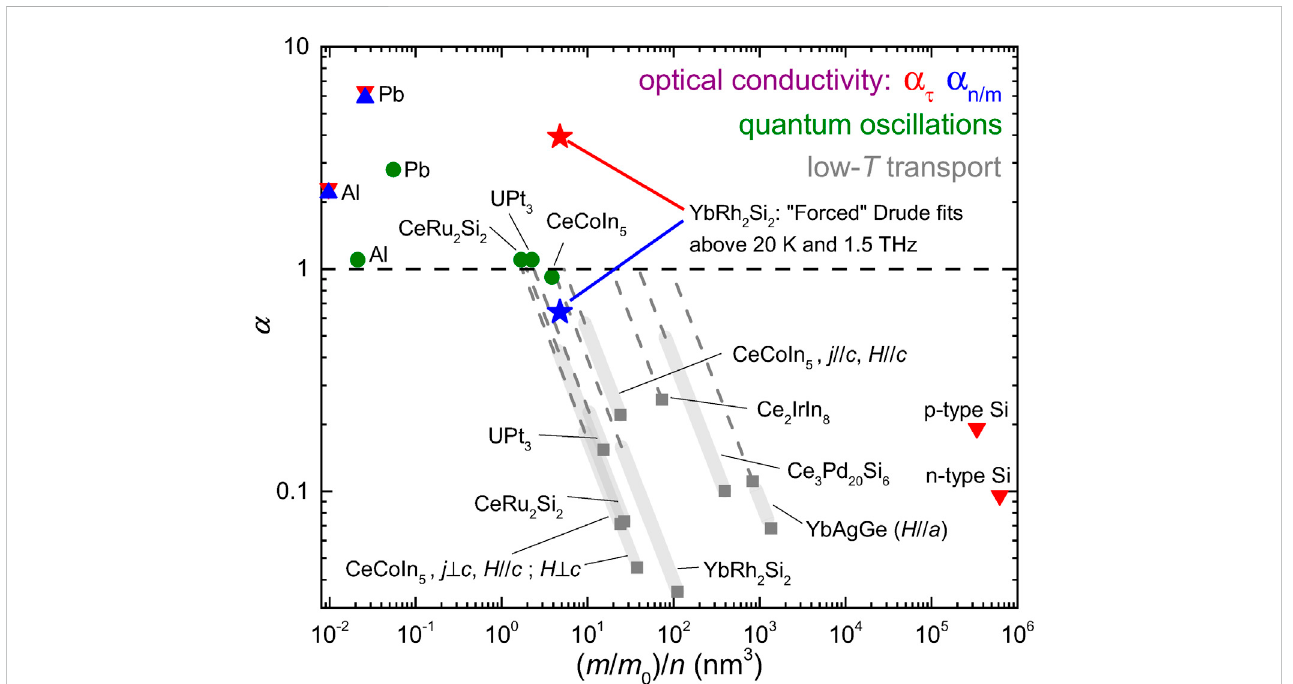
FIGURE 4 ResultsofvariousPlanckiananalyses,inadouble-logarithmicplotof α vs.( m / m 0 )/ n .Thedarkgreysquaresandthebroadlightgreylineswereobtainedin (Taupin and Paschen, 2022) from low-temperature transport measurements. The dashed grey lines are extrapolations to the dashed black α = 1 line of Planckian dissipation.Note that thegrey lines — α vs.( m / m 0 )/ n curves obtained fromEq.13 — are straightlinesof slope − 1 on thisdouble-logarithmic plot,with offsetsproportional to A ′ .Thegreencircles are α n / m values obtained in(Bruinetal.,2013)fromquantumoscillationdata.Theredandbluesymbolsare α τ and α n / m , respectively, determined in the present work from Drude fi ts to published optical conductivity data (see text). The fi ts for Pb, Al, and Si are of good quality in the temperature range where the scattering rates are linear in temperature due to electron-phonon scattering. For YbRh 2 Si 2 , by contrast, Drude fi ts fail in the strange metal regime (below 10 – 15 K in the dc resistivity). The α values (stars) were therefore extracted from Drude fi ts to data above 20 K and 1.5THz, where the fi t quality is reasonable. The discrepancy between α τ and α n / m is large in this case, which casts doubt on their signi fi